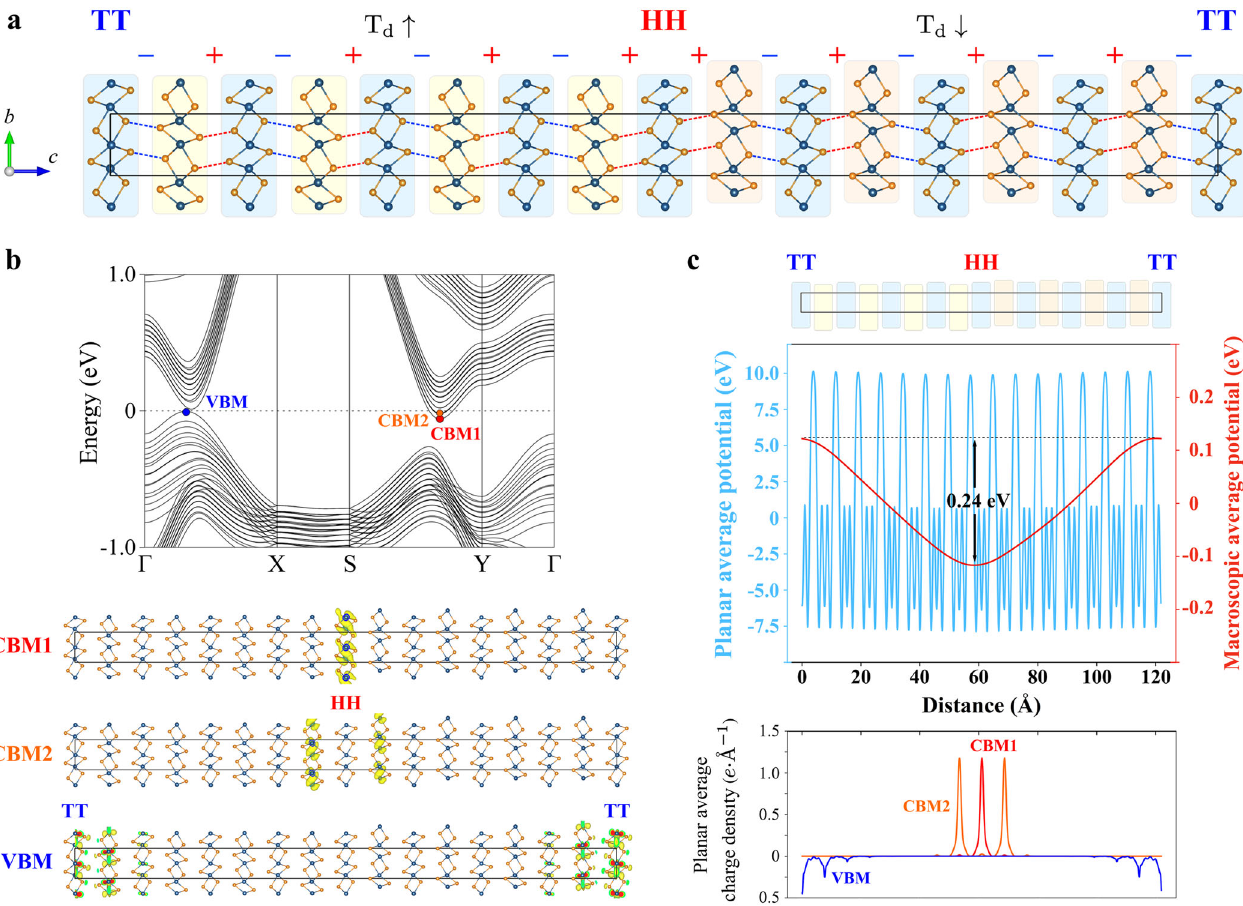
Fig. 4 First-principles calculations of the charged DWs in β -ZrI 2 . a a 1 × 1 × 8 supercell with the T d /T d arrangement containing the head-to- head (HH) and tail-to-tail (TT) DWs at the center and boundaries, respectively. The M trilayers are denoted with blue rectangles, and the P trilayers with positive and negative sliding displacements are highlighted with orange and yellow rectangles, respectively. b Electronic band structure and charge densities corresponding to the valence band maximum (VBM) and conduction band minimum (CBM1 and CBM2). The isosurfaces correspond to 0.01 e Å − 3 . c Planar and macroscopic average electrostatic potentials across the supercell and planar average charge densities of VBM and